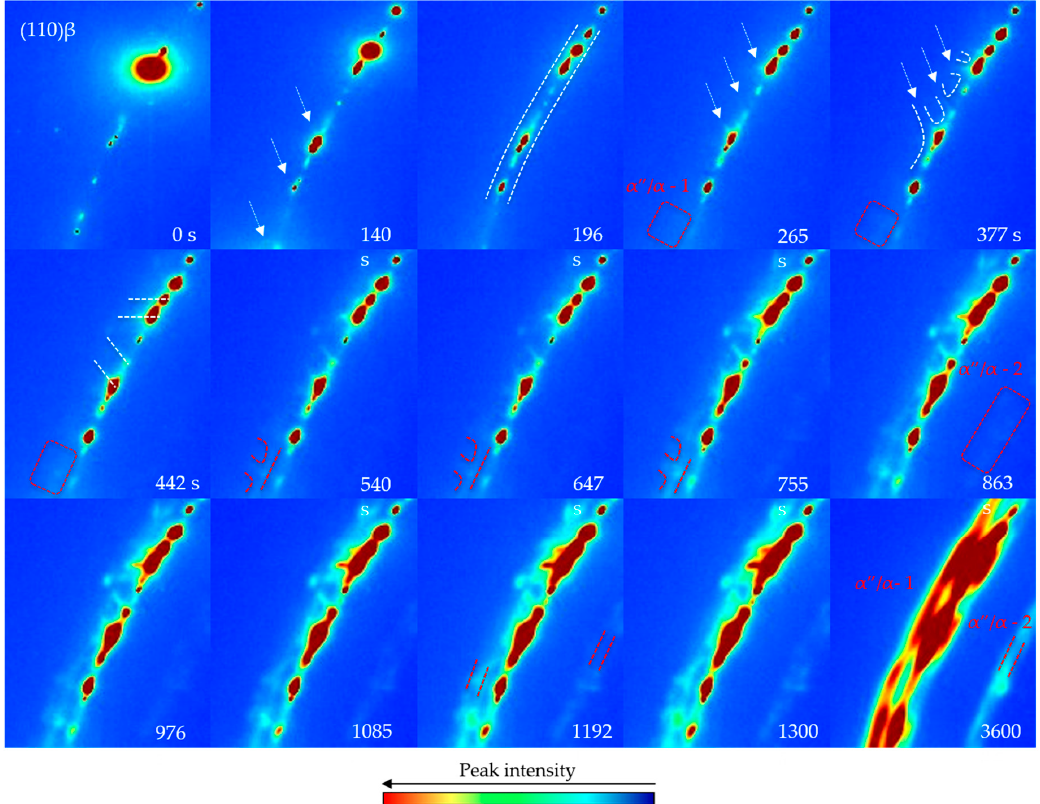
Figure 4. Sections extracted from the same areas of Debye–Scherrer rings depicting evolution of diffuse streaks (white arrows), their characteristic inclination (white dashed lines), and the appearance of double rings close to {110} β resulting from α and α ” iso .